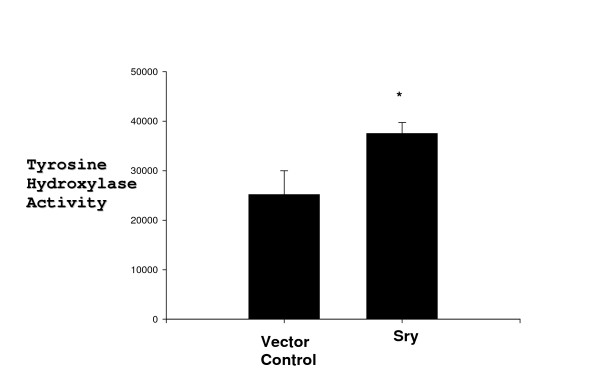
Tyrosine hydroxylase activity (measured as L-DOPA formed per minute per mg tissue, fm/min/mg) in adrenal gland 3 weeks after plasmid delivery (means, +/-s.e.m., * p <.05).